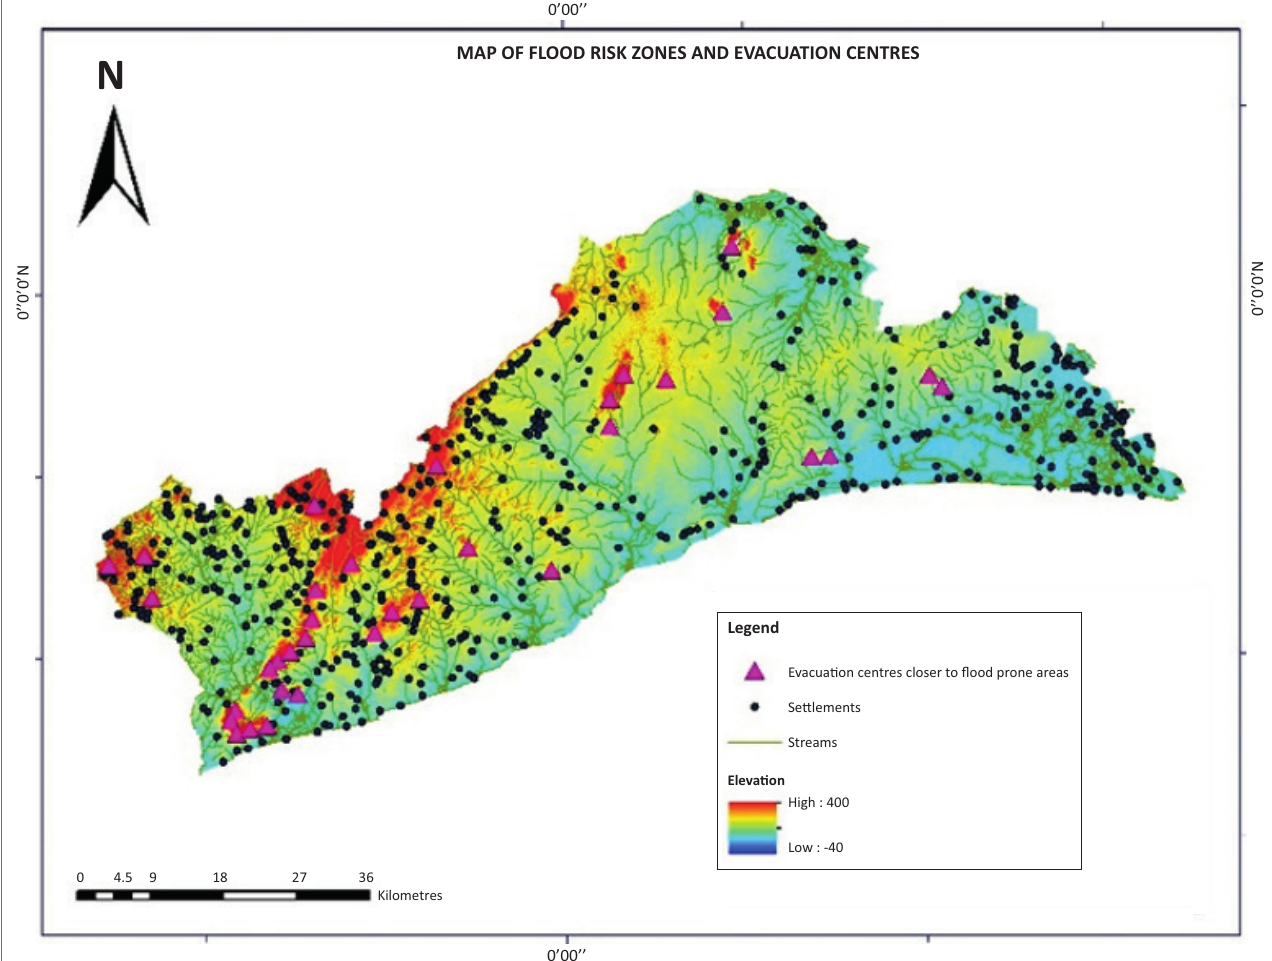
FIGURE 6: Flood-risk zones and closest evacuation sites for flood-prone